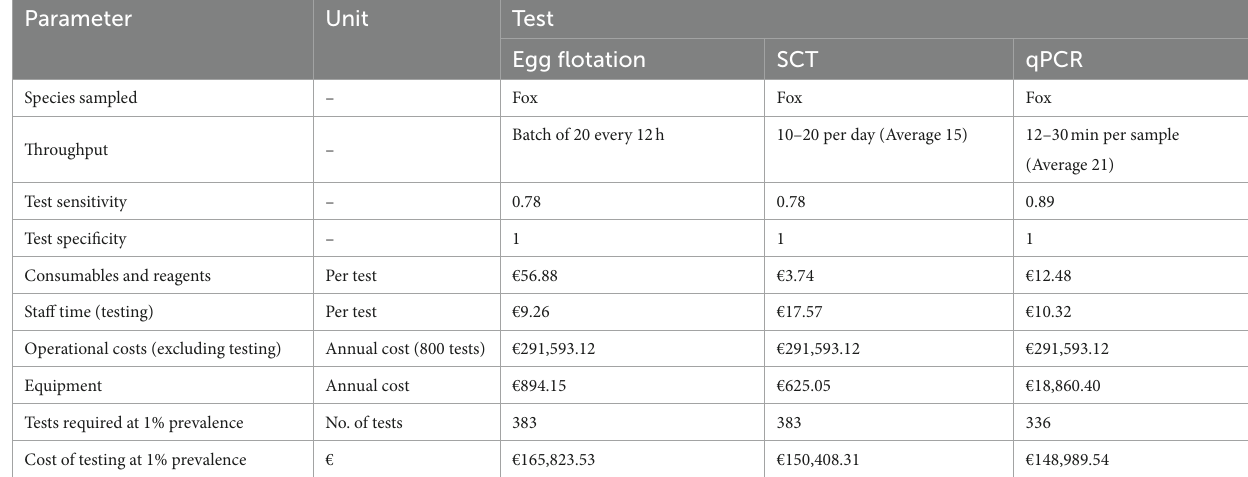
TABLE 4 Showing the cost-effectiveness of three different testing methodologies for E. multilocularis at detecting a 1% prevalence detection with 95% confidence (hypothetical